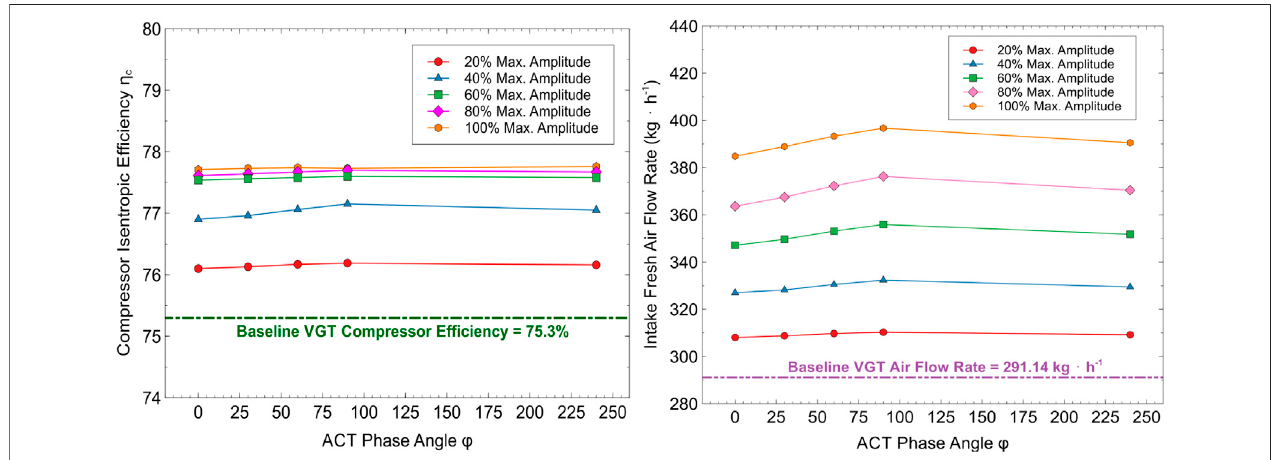
FIGURE 11 | Impact of amplitude ratio and phase angle on (left) : compressor isentropic ef fi ciency η c and (right) : intake fresh air fl ow rate.